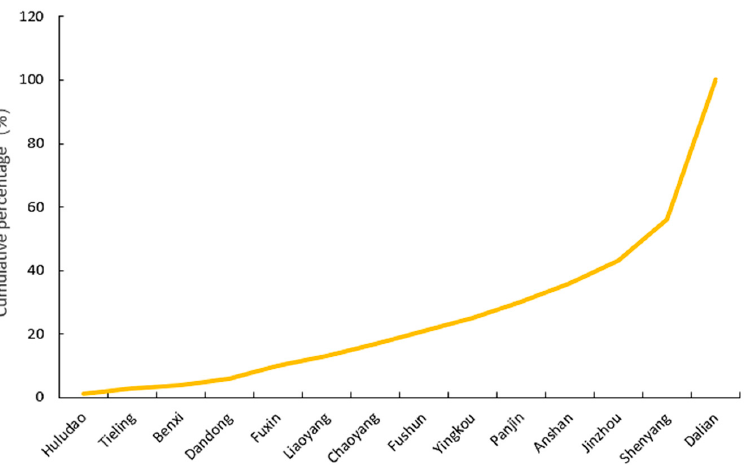
Figure 6. Lorentz Curve of the Spatial Distribution of the Number of Warehouse Supermarkets in Cities of Liaoning Province.